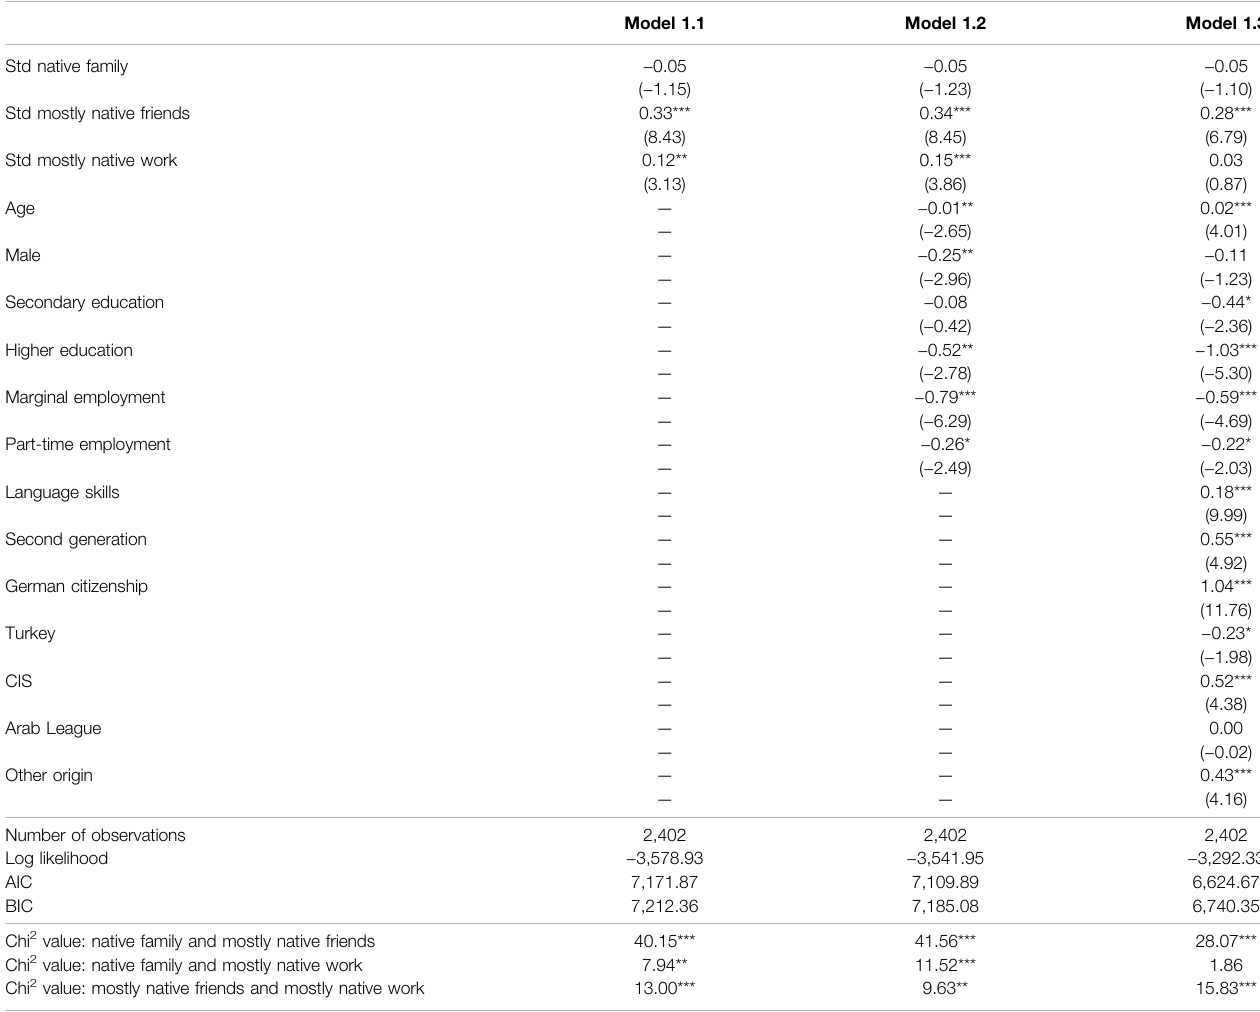
TABLE 1 | Cross-sectional ordered logit